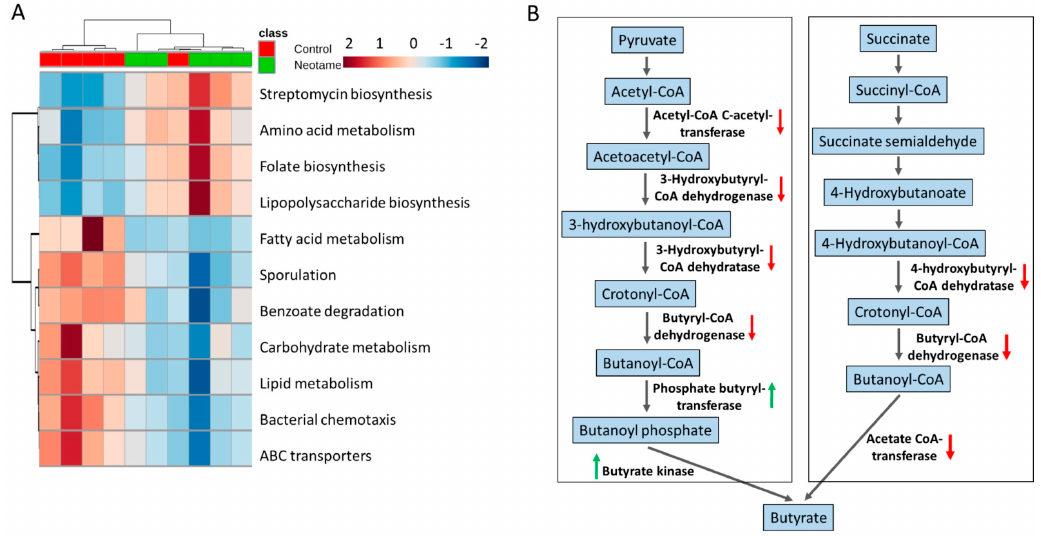
Figure 3. ( A ) The pattern of some key metabolic pathways in control ( n = 5) and neotame-treated mice ( n = 5) were different; ( B ) Multiple genes in two butyrate biosynthetic pathways have been decreased in neotame-treated mice.